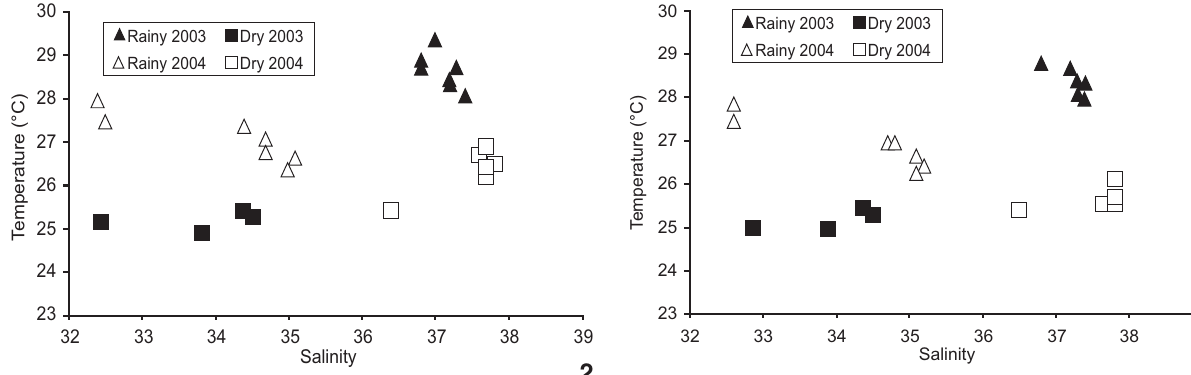
Figures 2-3. Temperature-salinity diagram of the water masses observed in the Caravelas River estuary and the adjacent coastal region: (2) surface; (3) near the